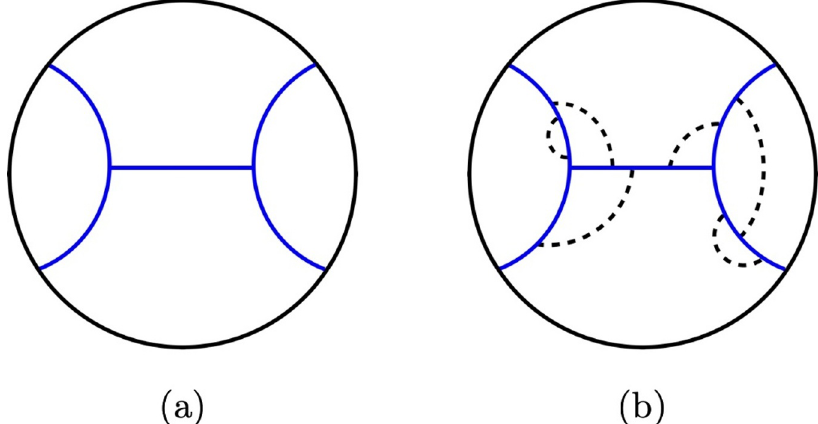
Figure 4 . (a) A Witten diagram, with a spatial slice of dS 2 drawn as a disc. The solid lines are scalars, and there is a single scalar exchange. This process is encoded in the boundary Schwarzian description as an operator, the reparameterized four-point function, endowing it with a coupling to the reparameterization (cid:12)eld. (b) The expectation value of the matter four-point function in the Schwarzian theory dresses the process with an in(cid:12)nite number of corrections involving exchanges of the reparameterization modes, indicated with dotted